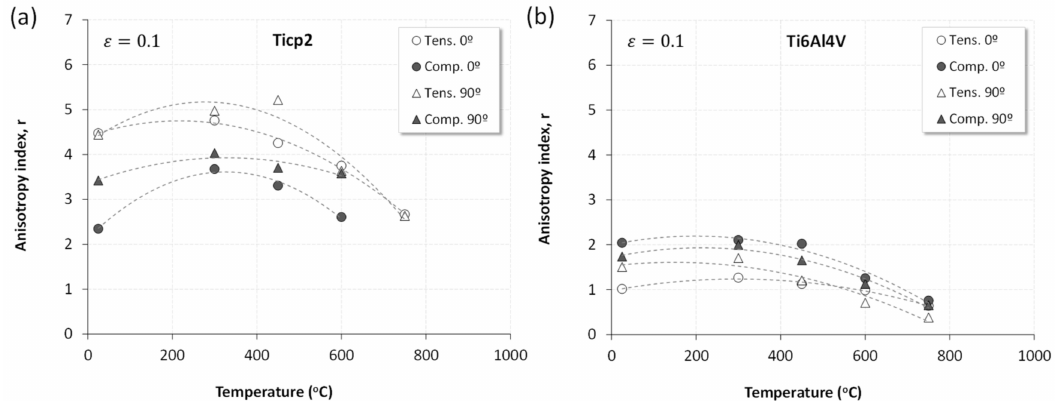
Figure 17. Tensile and compressive anisotropy r-values in the rolling (0 ◦ ) and transverse (90 ◦ ) directions as a function of temperature for ε = 0.1. ( a ) Ticp2 0.002 s − 1 ; ( b ) Ti6Al4V 0.002 s − 1